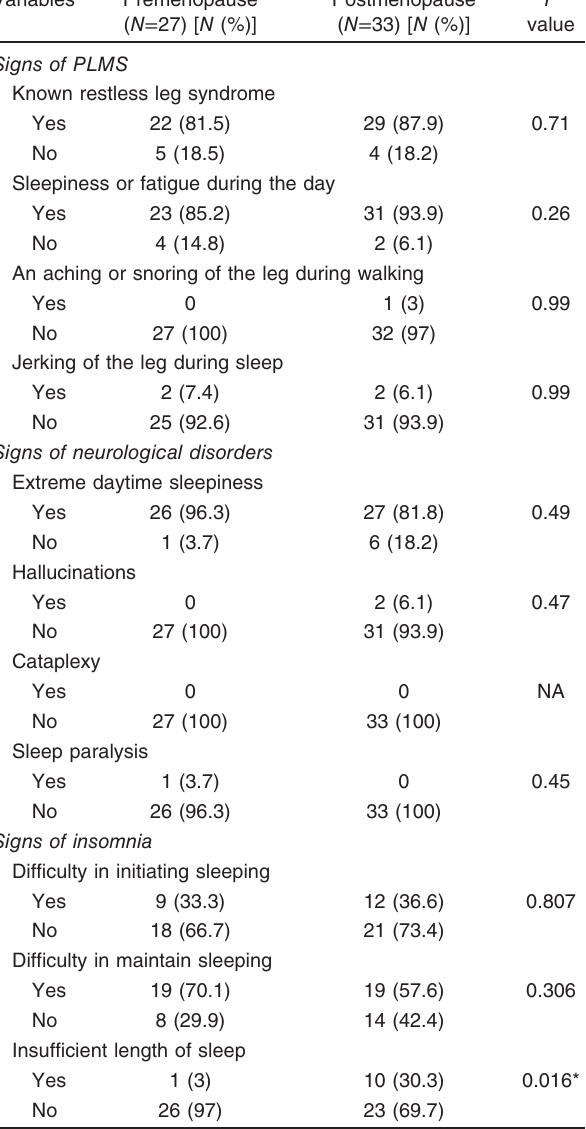
Table 4 Signs of periodic leg movement syndrome, neurological disorders and insomnia of the study groups